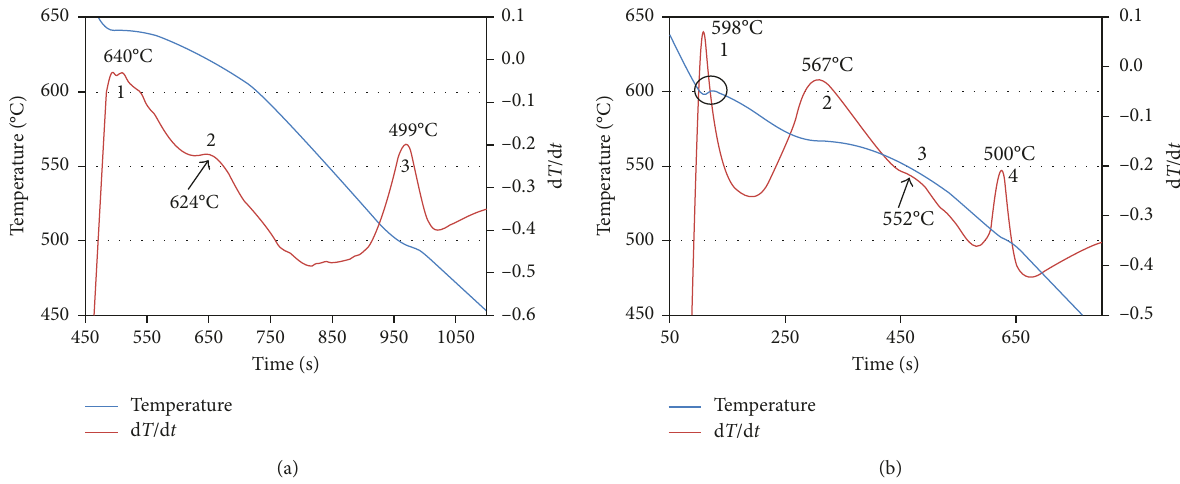
Figure 2: Temperature-time curves and their first derivatives obtained from (a) B0-base alloy showing 1: precipitation of α -Al; 2: pre- cipitation of α -Fe intermetallic phase; 3: precipitation of Al–Al 2 Cu eutectic and (b) D0-base alloy showing 1: precipitation of α -Al; 2: precipitation of Al–Si eutectic reaction; 3: precipitation of -Fe intermetallic phase; 4: precipitation of Al–Al 2 Cu π